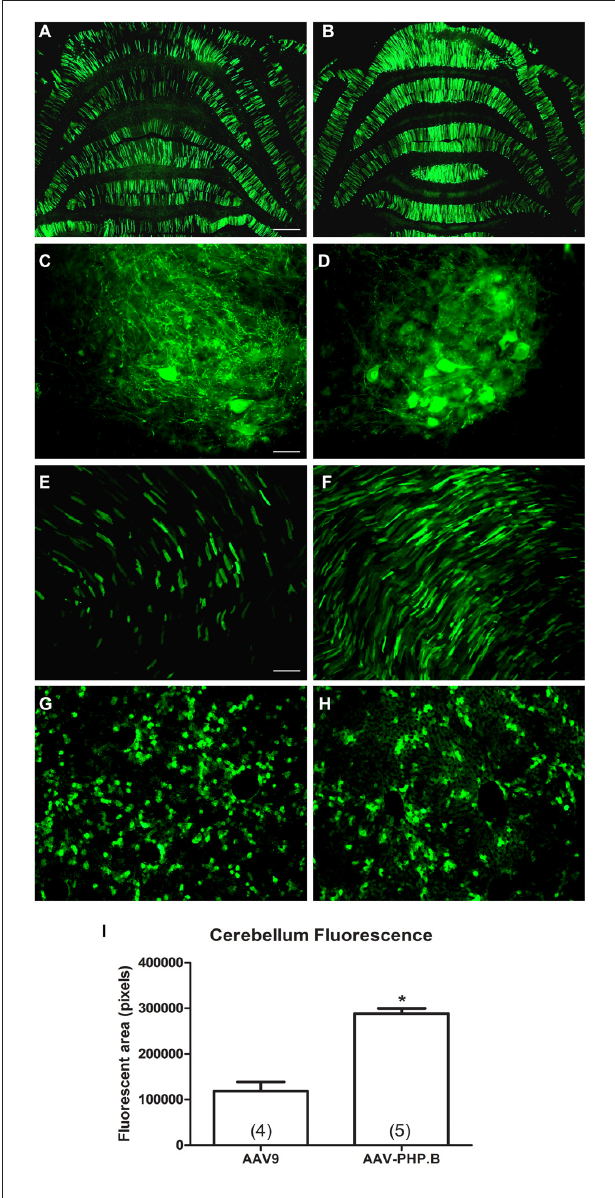
FIGURE 5 | AAV-PHP.B provides increased transduction efficiency in the CNS relative to AAV9. Neonatal rats were injected intravenously with the CBA promoter construct packaged into either AAV9 or AAV-PHP.B under equal conditions, with a 4 week expression interval. (A,B) There was stronger GFP expression in the cerebella of rats administered AAV-PHP.B. (C–F) The same pattern was found in the spinal cord (C,D) and the heart (E,F) . (G,H) Interestingly, AAV-PHP.B did not appear to similarly increase expression in liver, which is consistent with improved neuronal targeting. (I) GFP-positive area in the cerebellum ( t -test, p < 0.001, n = 4–5/per AAV capsid serotype group). GFP immunostaining in (A–H) . Bar in (A) = 536 µ m, same